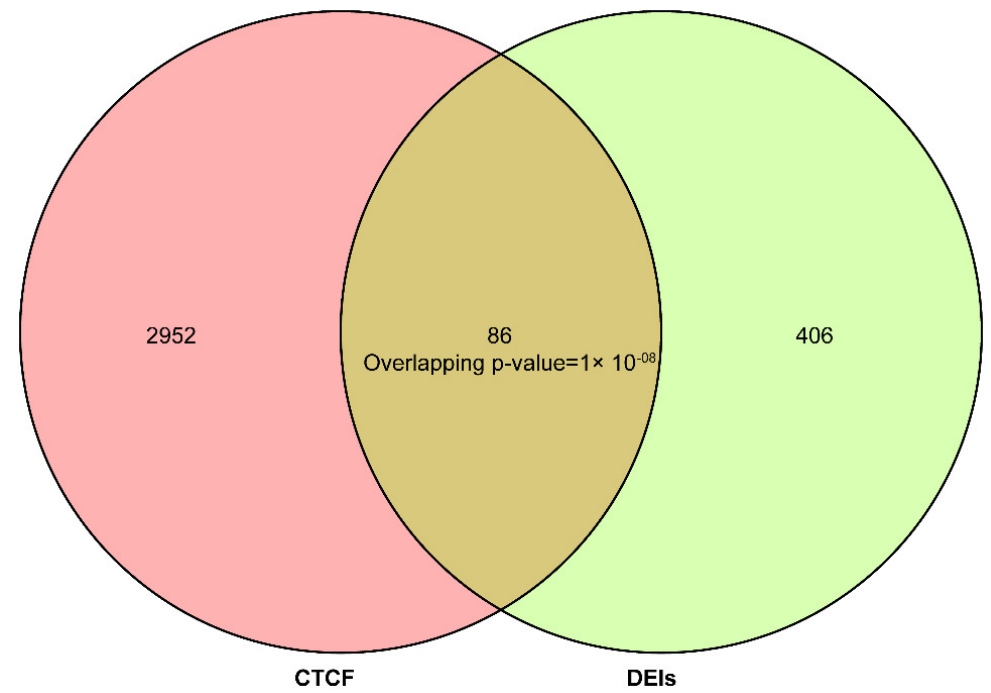
Figure 8. Veen plot of genes in differential peaks ( left ) and genes with transcribed differentially expressed isoforms (DEIs, right ).